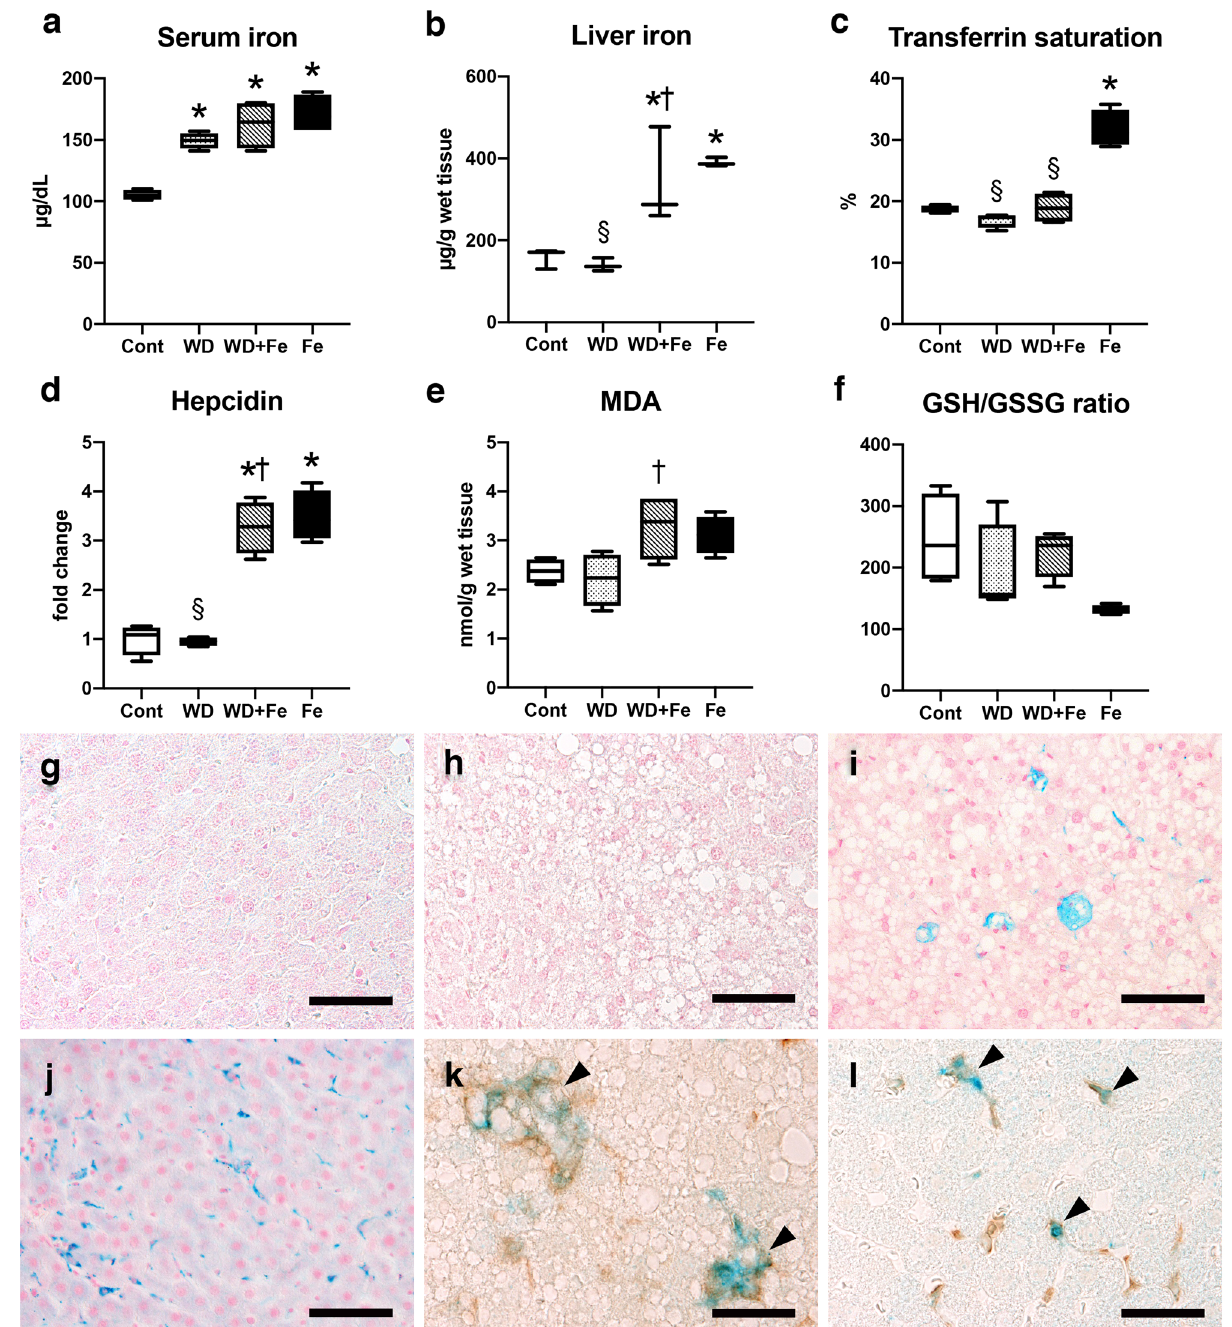
Figure 3. Blood biochemical data of ( a ) serum iron, ( b ) liver iron content, ( c ) transferrin saturation, and ( d ) hepatic expression of hepcidin mRNA at weeks 26. ( d ) Data were normalized to 18S rRNA and expressed as fold change from control group. ( e ) Hepatic content of malondialdehyde (MDA) at weeks 26, assayed by thiobarbituric acid ‐ reactive substances method. ( f ) Ratio of Hepatic content of glutathione (GSH)/oxidized glutathione (GSSG) at week 26. Data are presented as box and whiskers (n = 4/group). * P < 0.05 versus Cont, † P < 0.05 versus WD, and § P < 0.05 versus Fe by one-way ANOVA followed by Tukey’s multiple comparison. Images of Perls’ iron stain in the liver of ( g ) control, ( h ) WD, ( i ) WD + Fe and ( j ) Fe groups at week 26. Bar; 50 μm. IHC for Iba1 combined with Perls’ iron stain in ( k ) WD + Fe and ( l ) Fe groups at week 26. Arrowheads indicate iron accumulation (stained blue) in Iba1-positive macrophages/Kupffer cells (stained brown). Bar; 30